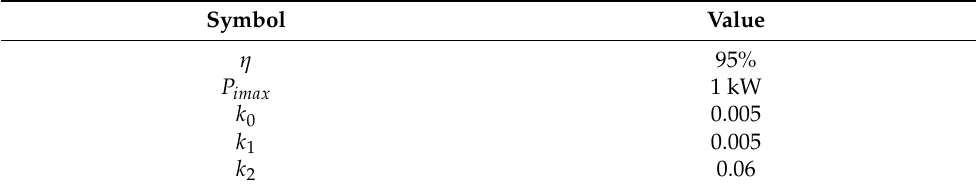
Table 3. Inverter simulation